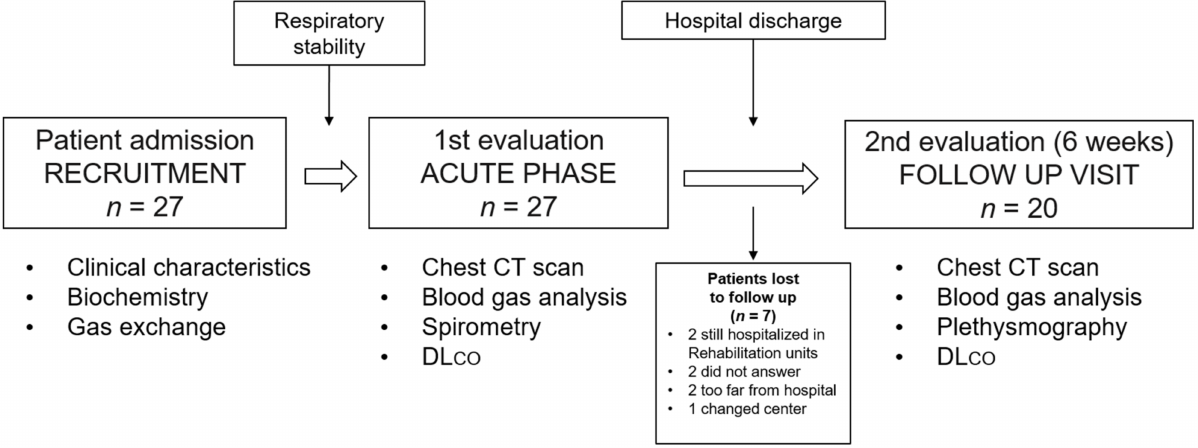
Figure 1. Flow chart of the study protocol. Seven patients were lost to follow up. DLco: lung diffusion capacity for carbon